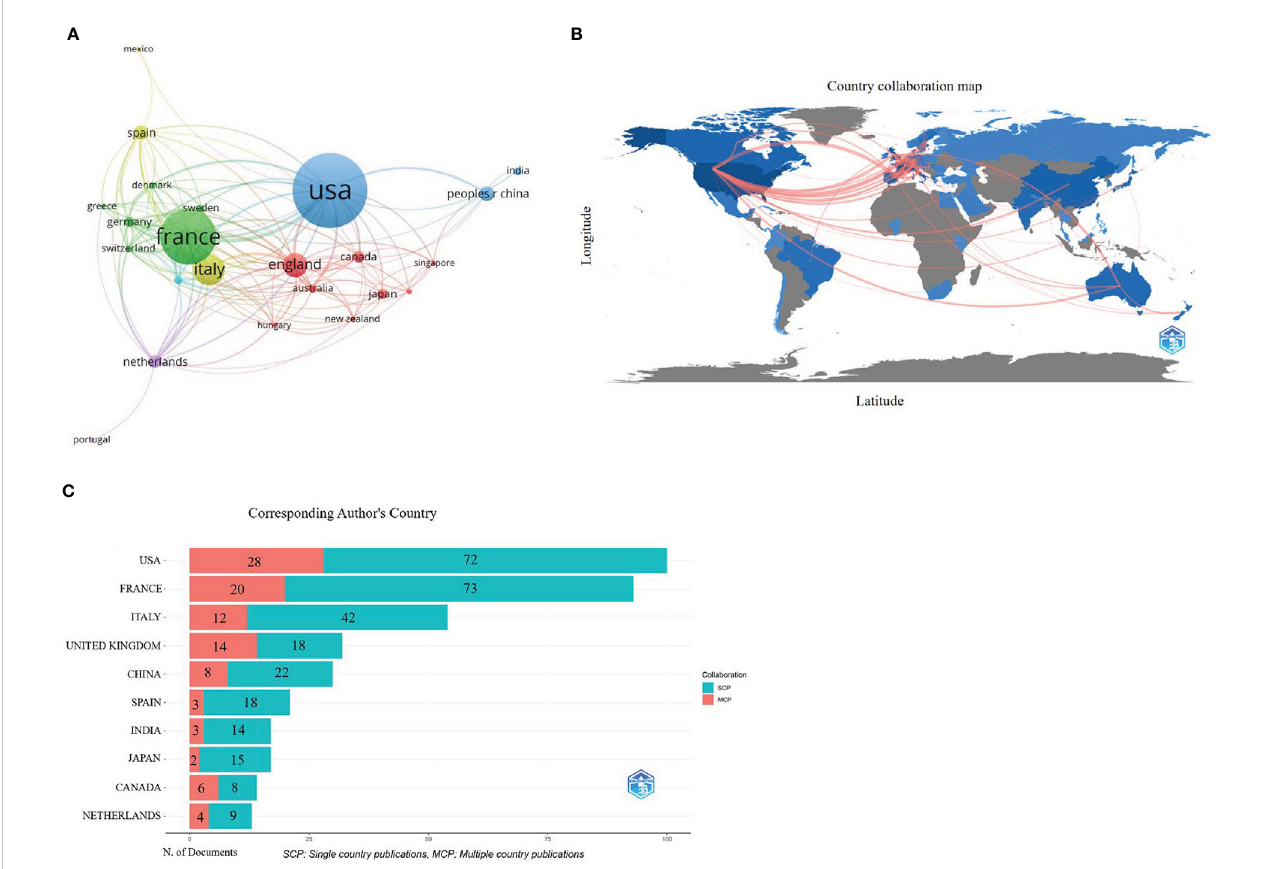
FIGURE 3 Countries/regions co-authorship analysis. (A) Cluster diagram of countries/regions (over 5 occurrences). Publication visualization map of 23 countries, forming 5 cooperation clusters (nodes with the same color). Node size represents the number of publications. Clusters with the same color represent closer cooperation. The lines represent the country ’ s collaboration. (B) Geographic maps in publication and collaboration of countries/regions. The blue color indicates the output rate of publications, the darker the blue color indicates more publications, and the gray color indicates no publications. The red line represents the cooperation between countries/regions. The thicker the line, the stronger the cooperation. (C) Histogram of cooperation in the top 10 productive countries/regions. The x-axis represents publication production, the y-axis represents countries. The red section represents multiple country/region collaborative publications (MCP), and the green section de fi nes single country/region publications (SCP). The numbers in the bar chart represent the number of publications.